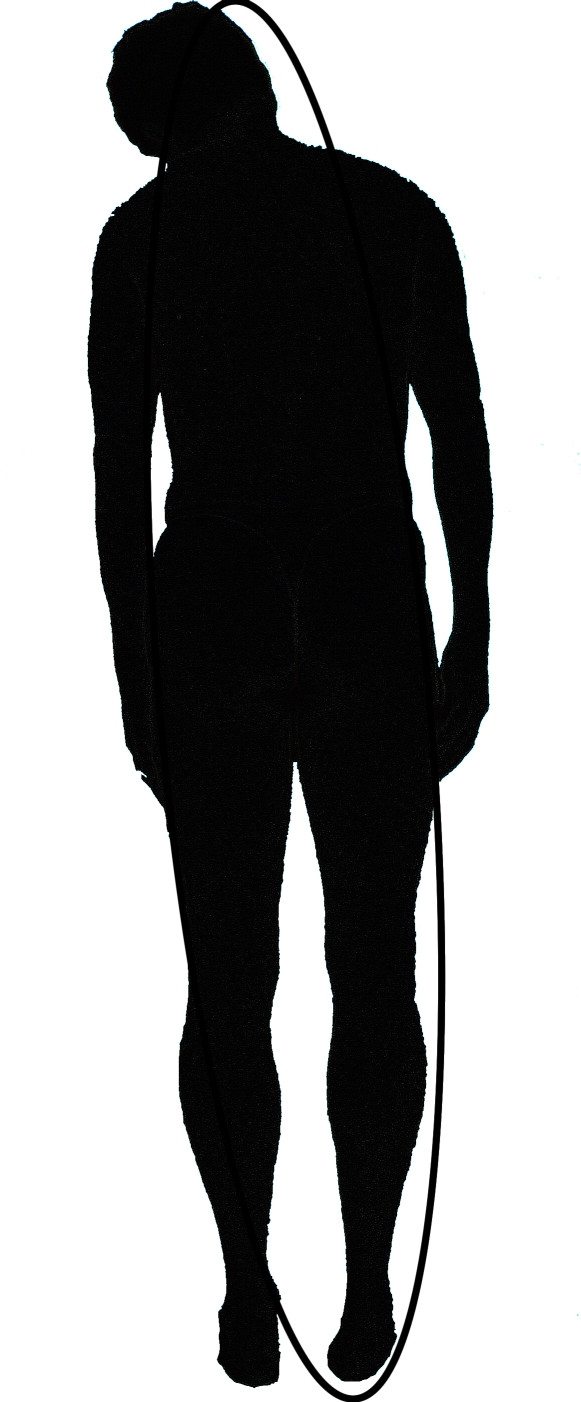
Simulated patient photography demonstrating the lateral tension concept. The basic elements of the model are included.